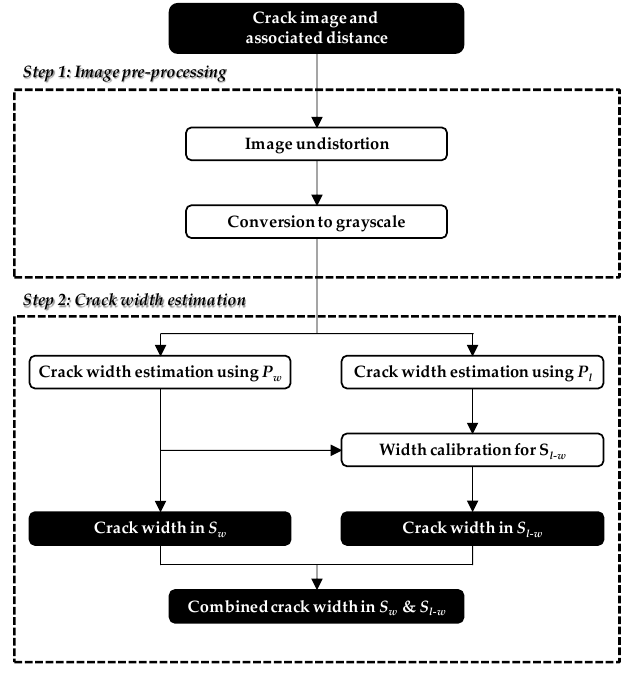
Figure 6. Schematic outline of the hybrid image processing strategy.